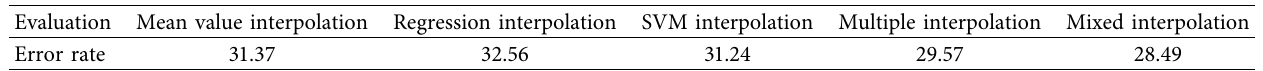
Table 2: Error rate of five interpolation methods under 5% data missing